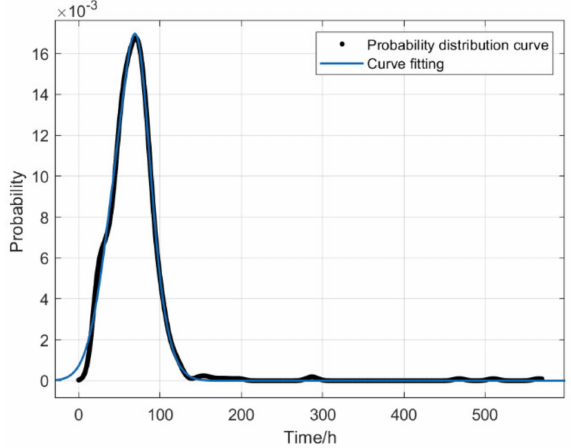
Figure 7. Probability distribution fitting